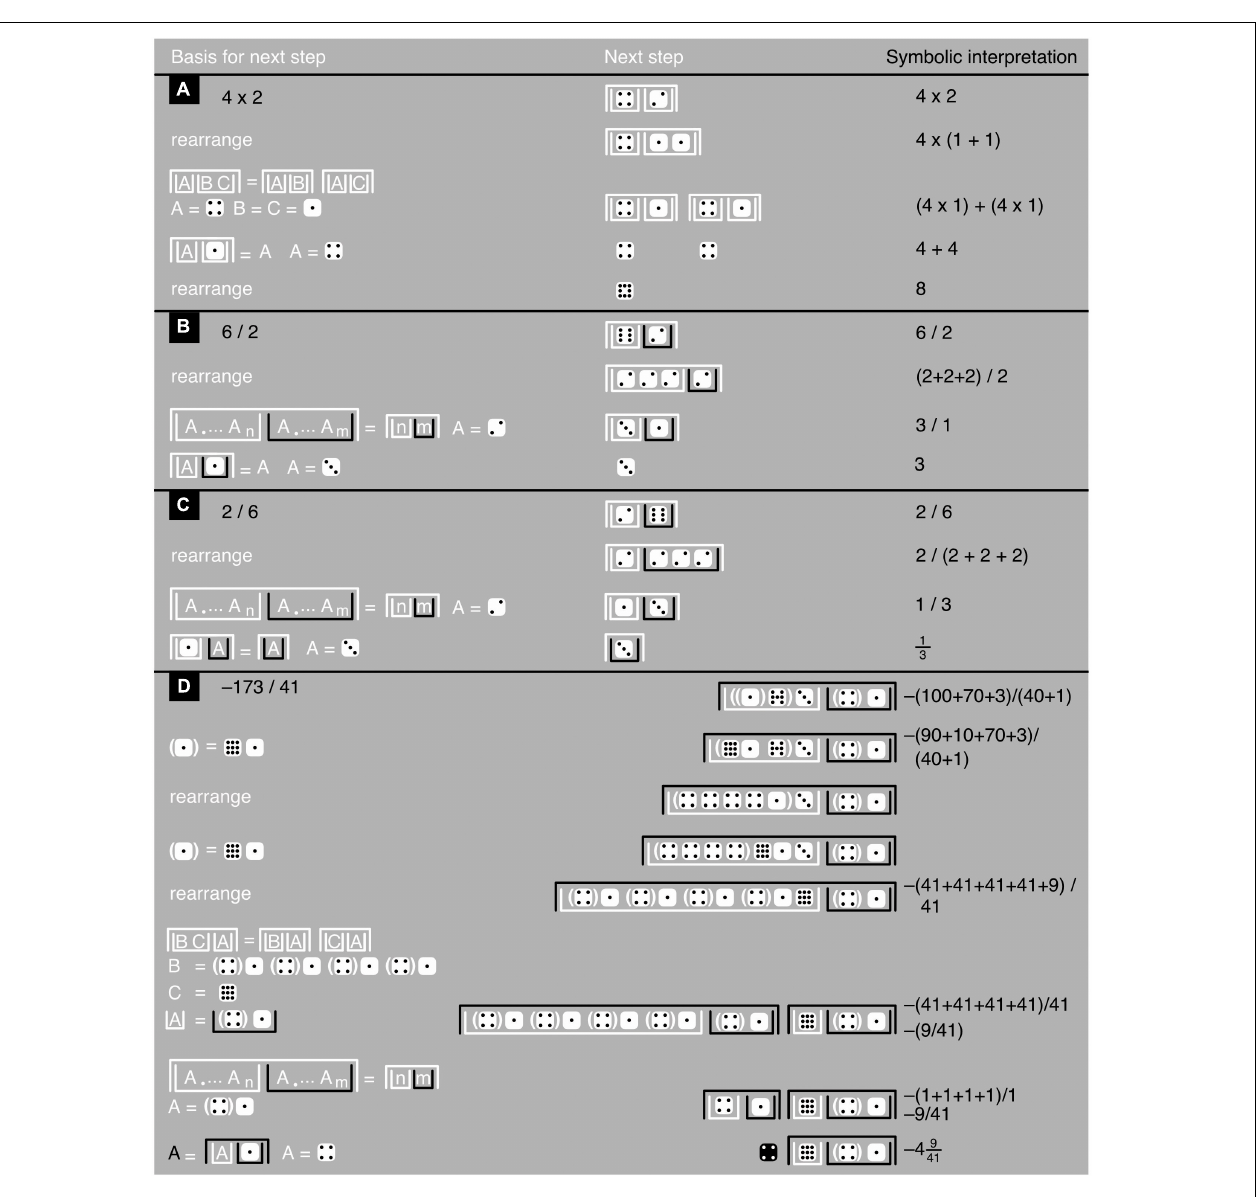
FIGURE 8 | Iconic multiplication and division. (A–D) Show examples with, based on Figure 7 axioms and theorems, the justification of each next step toward a problem’s solution (left), the step itself (middle), and a symbolic interpretation (to avoid excessive clutter, the last example has only a few, key symbolic interpretations). The last example shows how to deal with relatively large numbers and with a division’s irreducible remainder. All logarithms and exponents are assumed to have the same arbitrary